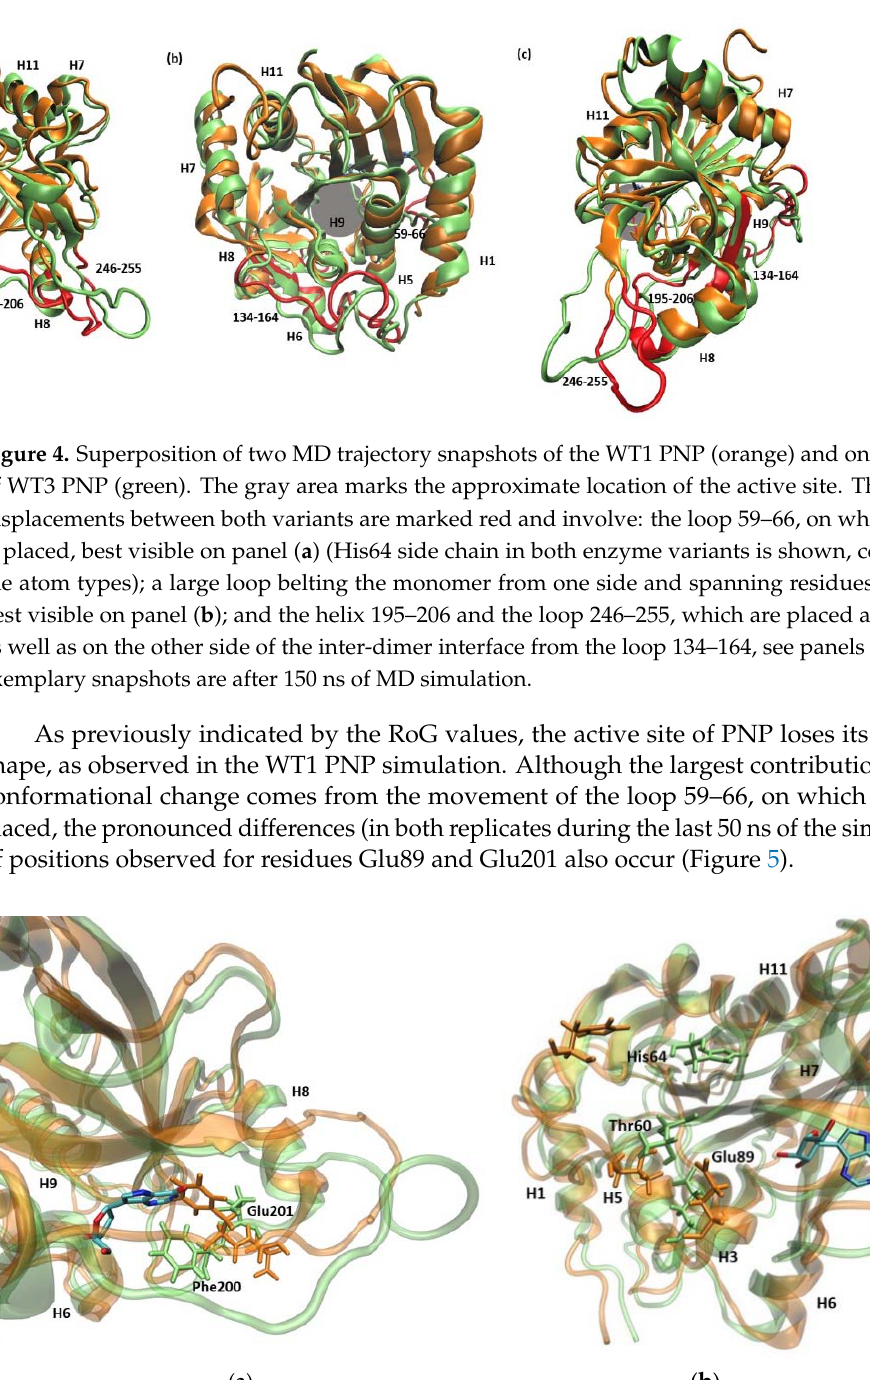
Figure 3. Root mean square fluctuations (RMSF) calculated for the last 50 ns of the simulation of all ( a ) and active site amino acids ( b ), observed in MD simulations for various PNP forms: trimeric WT3 PNP (black); monomeric WT1 PNP (green), trimeric 6Ala3 mutant (blue), and monomeric 6Ala1 mutant (red).